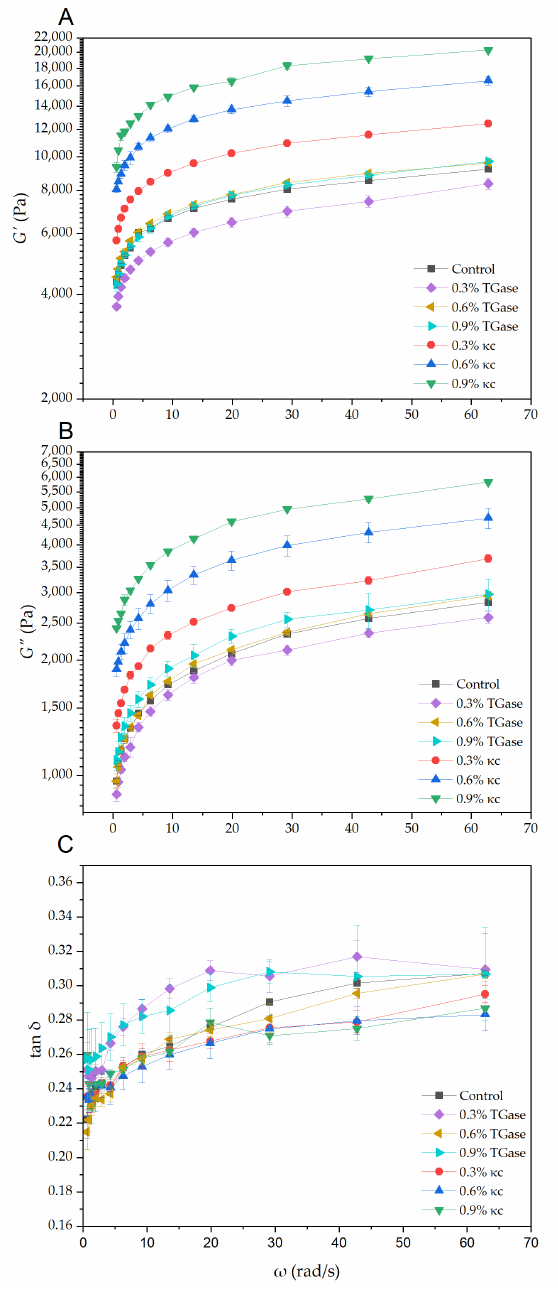
Figure 3. ( A ) Storage modulus (G ′ ); ( B ) loss modulus (G″); and ( C ) loss tangent (tan δ = G″/G′ ) vs. angular frequency of printing material treated with TGase and κc at 0.3, 0.6 and 0.9%.